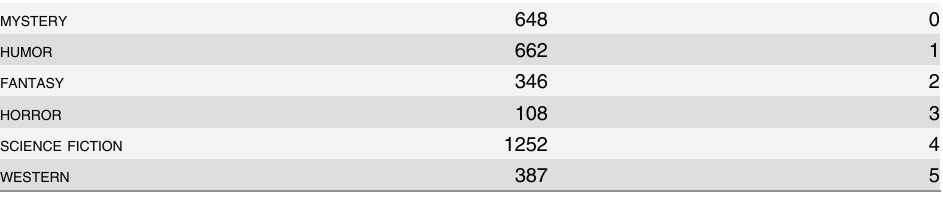
Table 1. List of genres, numbers of instances found and unique ids for each class (i.e,